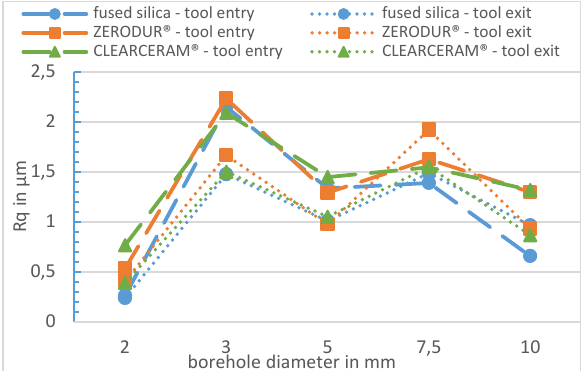
Fig. 2. measured roughness Rq at the tool entry and exit points It can be seen, that for all materials, the 2, 3 & 5 mm diameter holes have higher roughness at the tool entry than at the tool exit. The same applies to the 10 mm diameter, with the exception of fused silica. Possibly the material has an influence on the process result here, which is currently still being investigated. In addition, the roughness at the tool entry tends to be lower or the same for all three materials for the 7.5 mm diameter borehole. The roughness differences between the two machining techniques are most noticeable. The roughness values for helical machining are generally higher (3 mm & 7.5